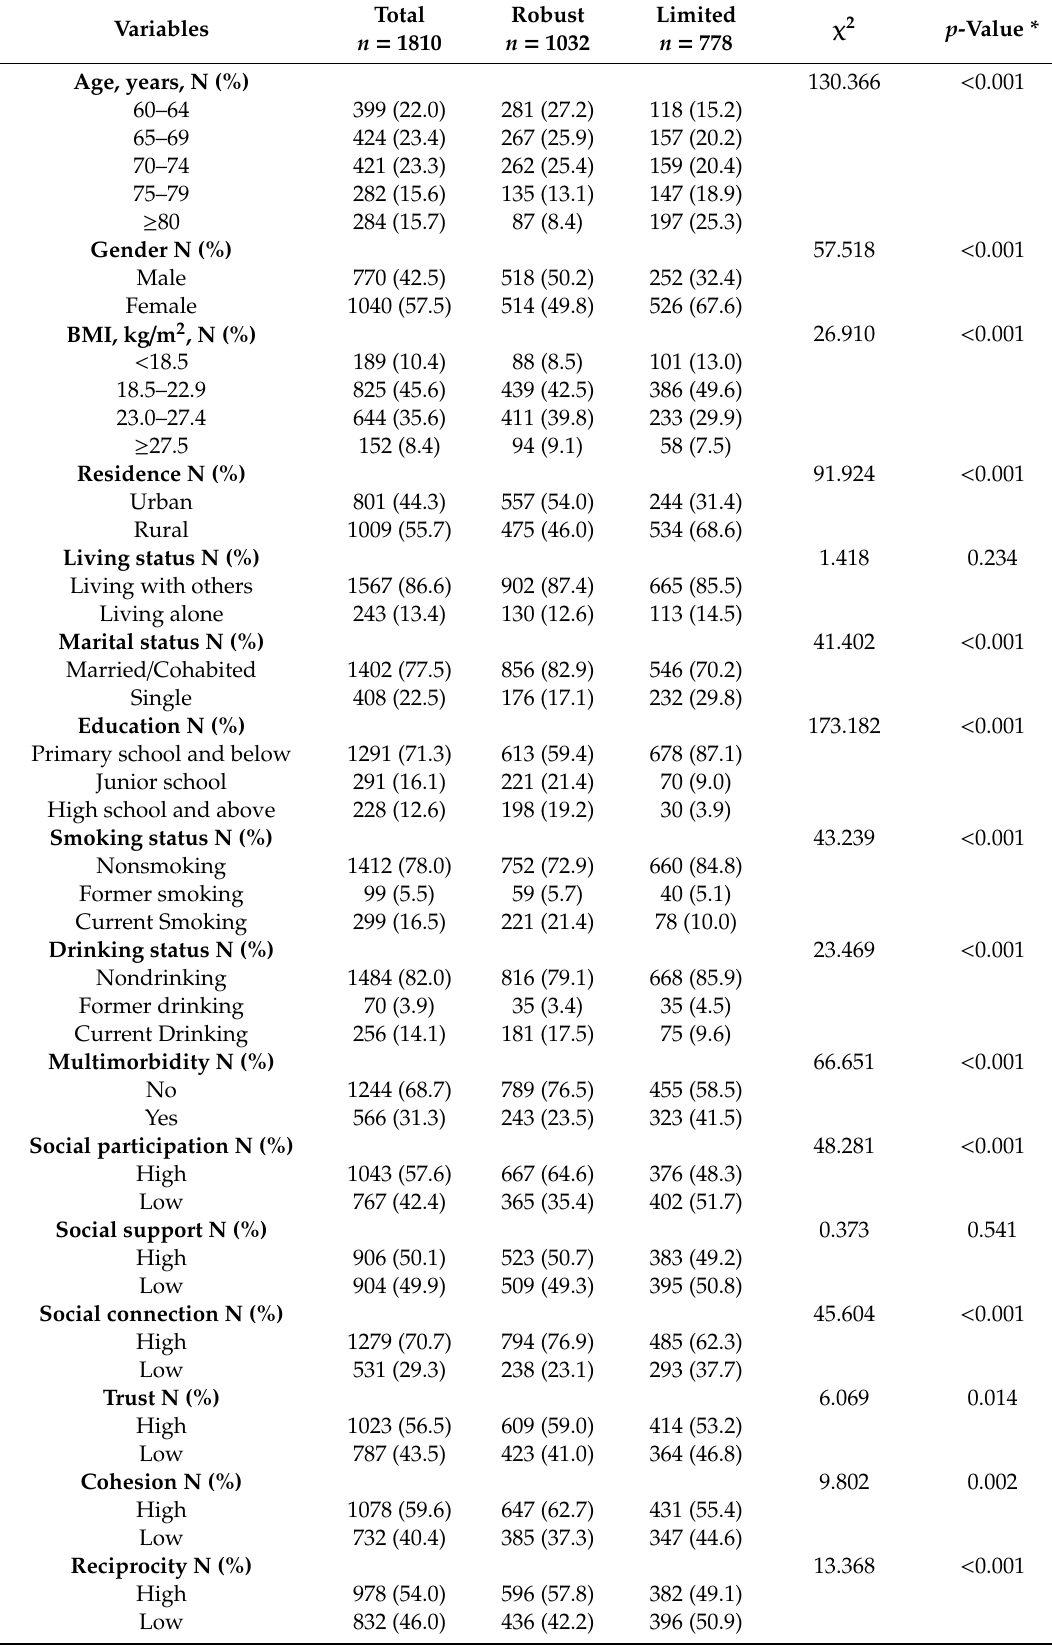
Table 1. Descriptive results of participants characteristics (N =